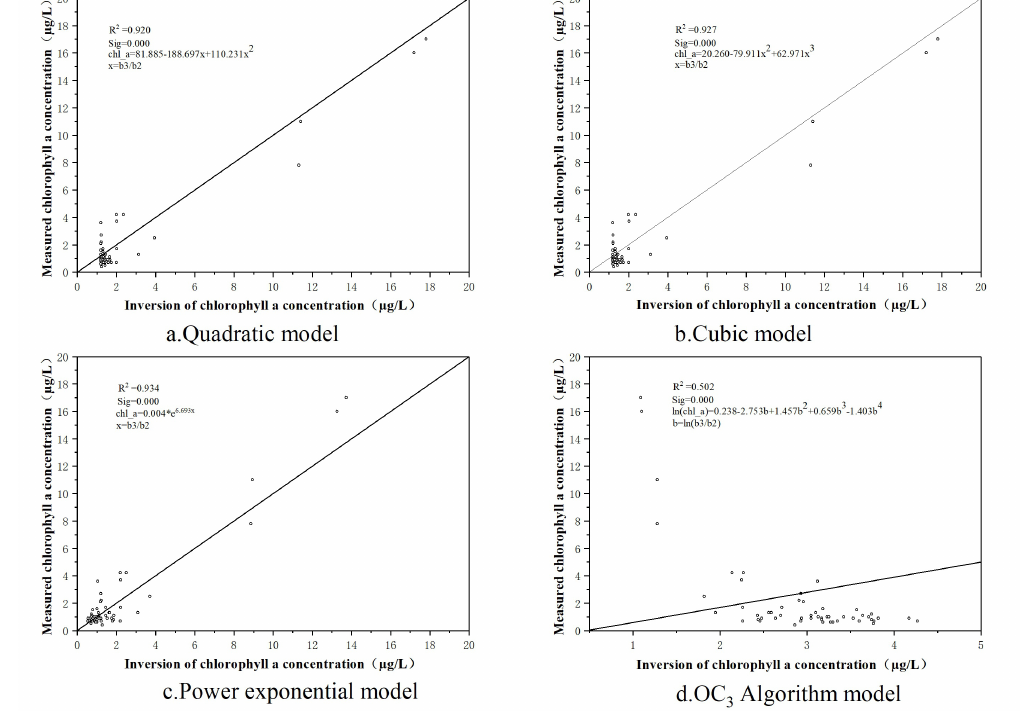
Figure 3. Accuracy regression analysis